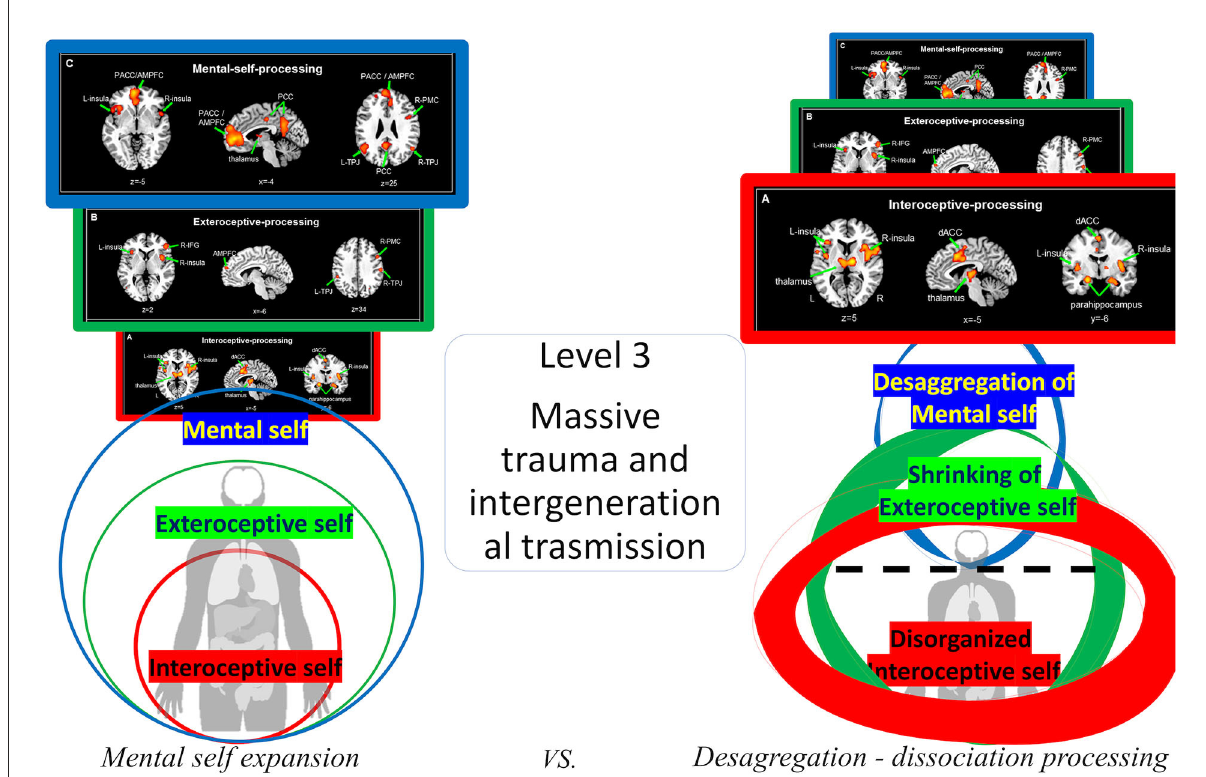
FIGURE8 Visual representation of the desaggregation of the mental self